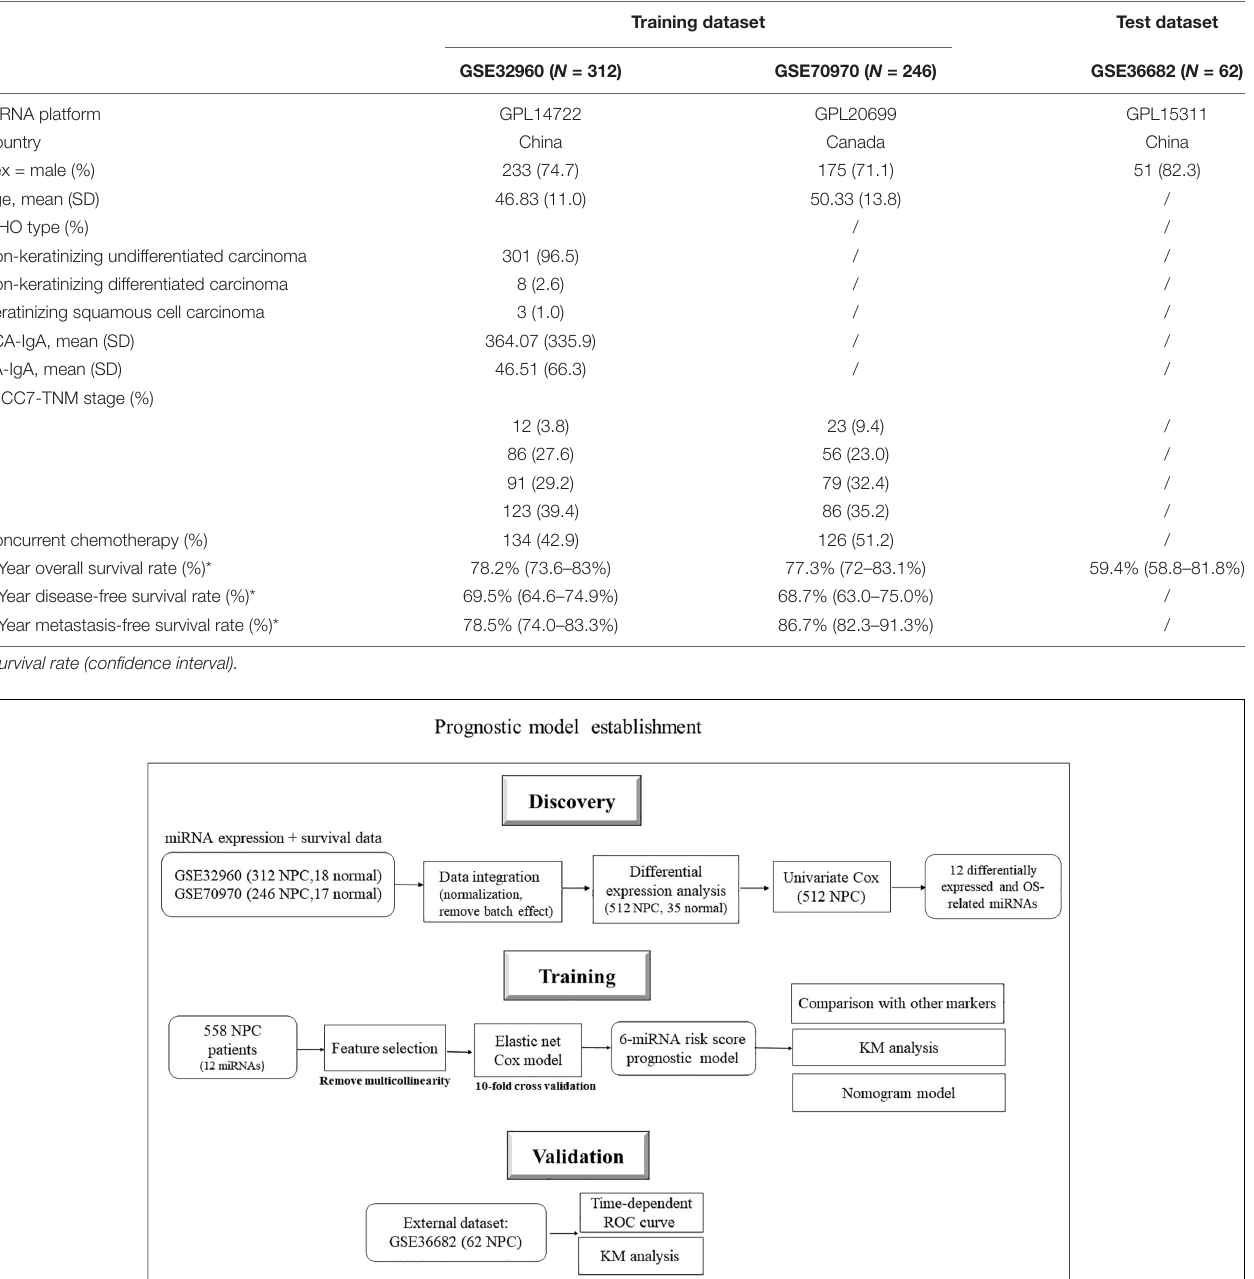
TABLE 1 | Demographics of the three NPC cohorts.